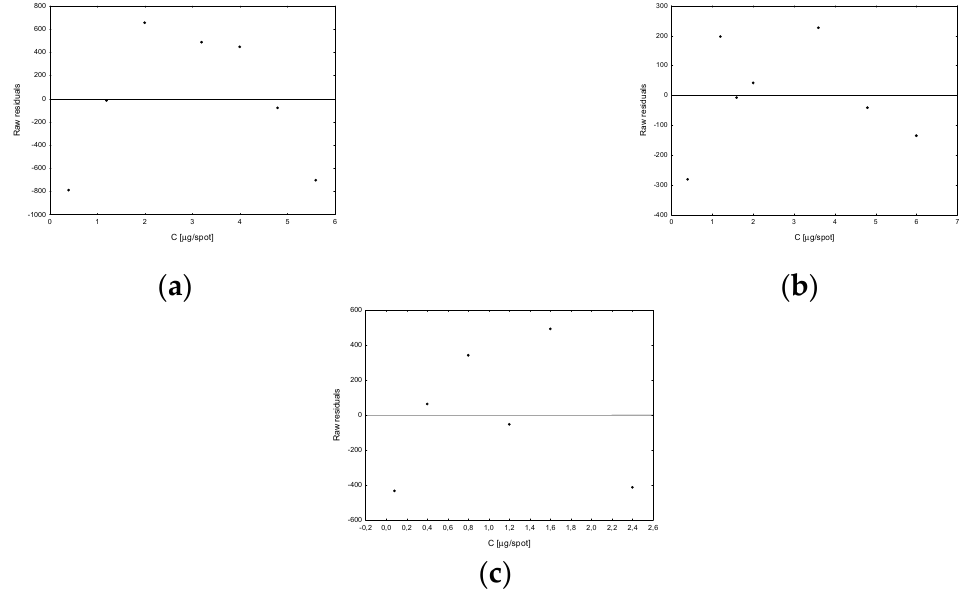
Figure 5. Plots of residuals calculated for vitamin D 2 ( a ), D 3 ( b ) and K 2 ( c ).